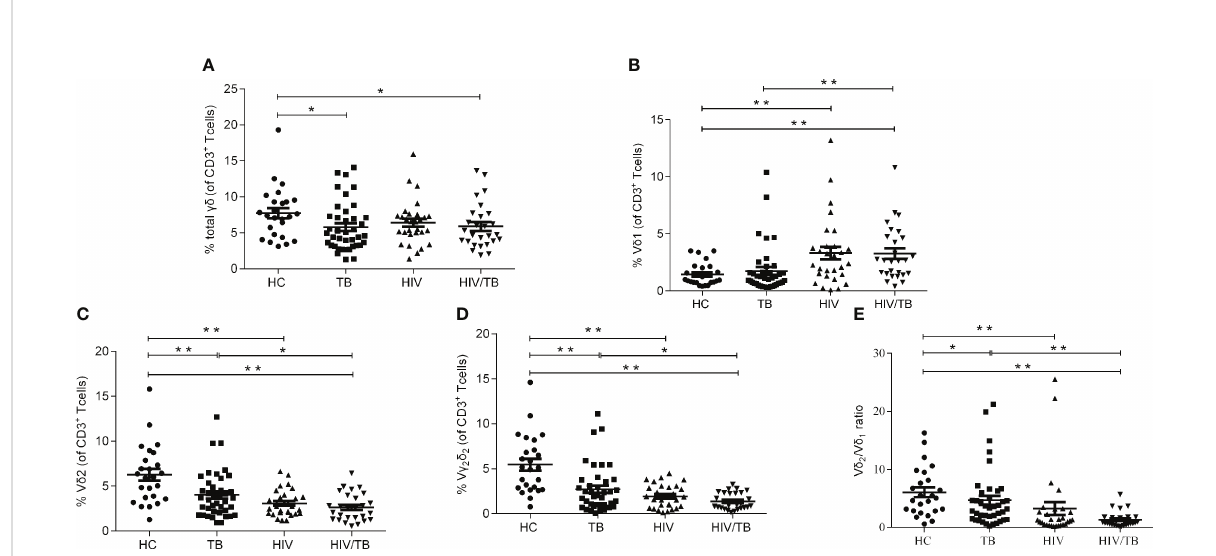
FIGURE 1 HIV or TB altered the balance of gd T cell subsets respectively. (A) Percentages of gd T cells in CD3 + T cells; (B) Percentages of V d 1 subset in CD3 + T cells; (C) Percentages of V d 2 subset in CD3 + T cells; (D) Percentages of V g 2 V d 2 subset in CD3 + T cells; (E) Ratios of V d 2 /V d 1 . P-value calculated using the Mann – Whitney U test. Statistically signi fi cant differences between the groups were indicated as follows: *P<0.05 and **P<0.01. Those that were not statistically signi fi cant were not marked intra group or inter